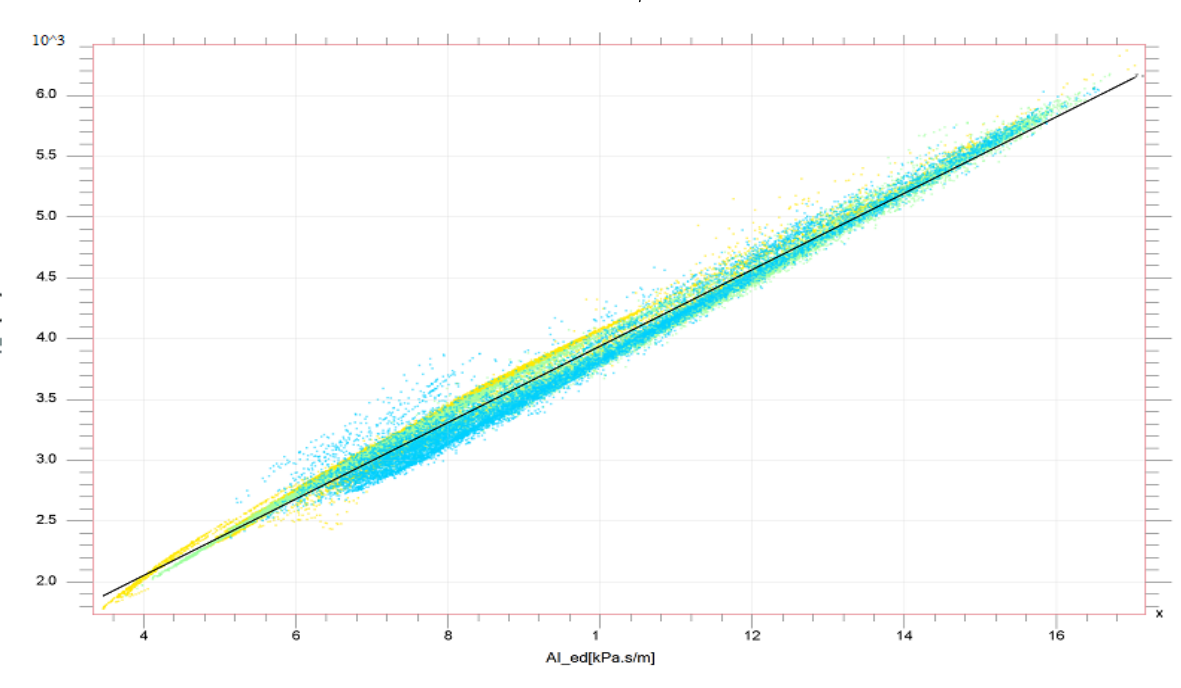
Figure 4. Crossplot of V p vs. AI, with V p (m/s), AI (kPa.s/m), and the correlation of R = 0.78. As the acoustic impedance volume was obtained from the seismic inversion results, a simple calculation was used to deduce the volume of the acoustic velocities, as shown in Figure 5a. Since the volumes of the ratio V p / V s and of V p were calculated, the volume of V s could, therefore, be directly deduced, as demonstrated in Figure 5b